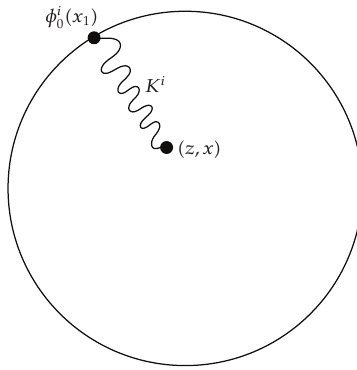
Figure 14: Witten diagram 1, created by Daniel Park.